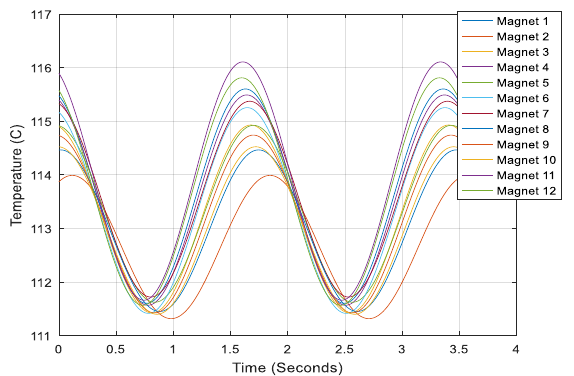
Figure 9. Sensor temperature for turn-to-turn short circuit in each slot.